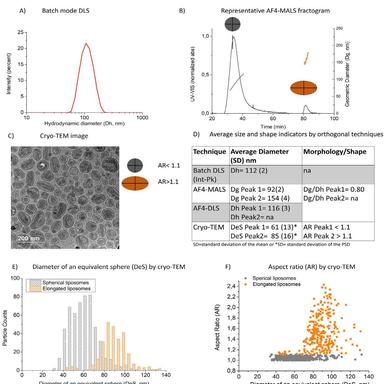
Bimodal liposomes with particles possessing different size and shapes. a) Batch DLS, intensity-based size distribution of liposomes at 100 x dilution in PBS. Averages of 10 measurements. b) AF4 fractogram reporting the UV-VIS absorbance (black) and the geometrical diameters (Dg) determined by MALS of the two peaks (grey and orange). c) Representative cryo-TEM image. (d) Table summarizing the size values measured by different techniques. e) Number based size distributions by cryo-TEM. f) Size vs aspect ratio